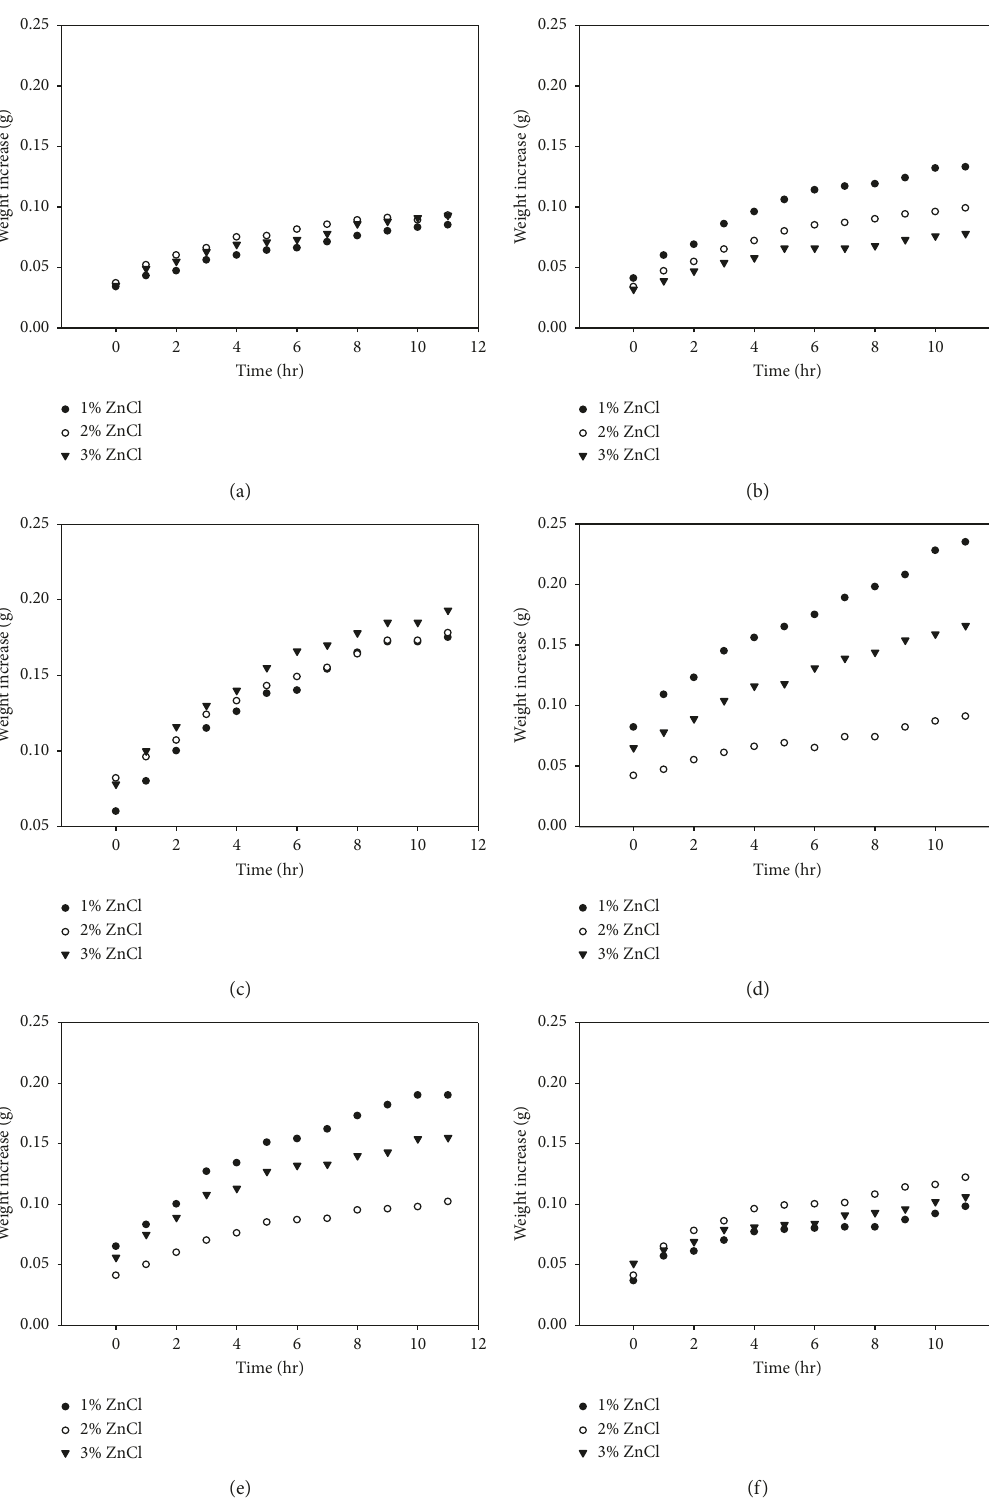
Figure 9: Water uptake of the epoxydized oils crosslinked with vital gluten or millet flour: weight increase of the epoxydized (a) cottonseed oil/gluten resin, (b) cottonseed oil/millet resin, (c) sesame oil/gluten resin, (d) sesame oil/millet resin, (e) sunflower oil/gluten resin, and (f) sunflower/millet